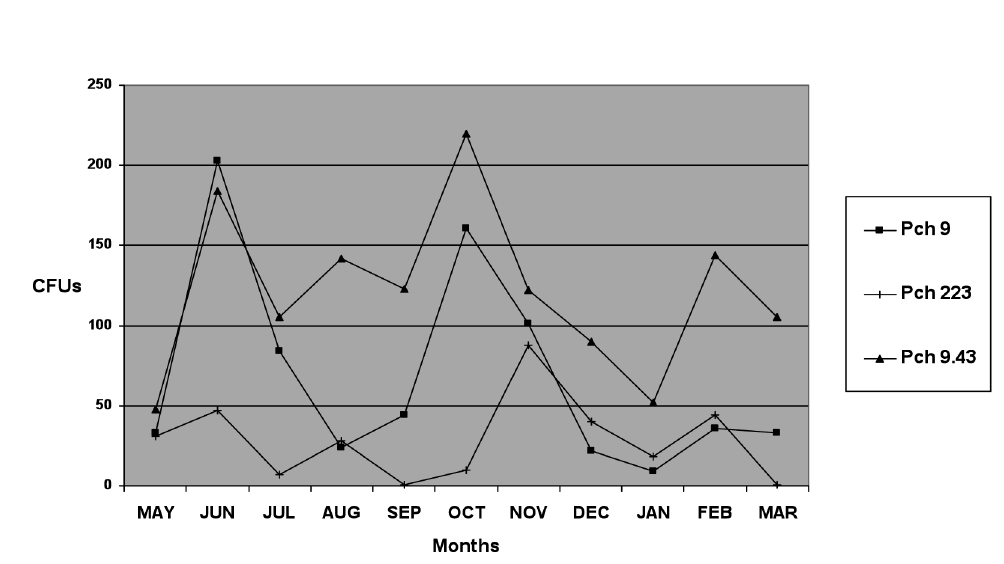
Figure 5. Evolution of recovery rates of three representative melanised (Pch 9.43) and albino (Pch 9 and Pch 223) isolates of P. chlamydospora artificially inoculated on grapevine soils. Recovery rates are expressed as total number of colony forming units (CFU) per